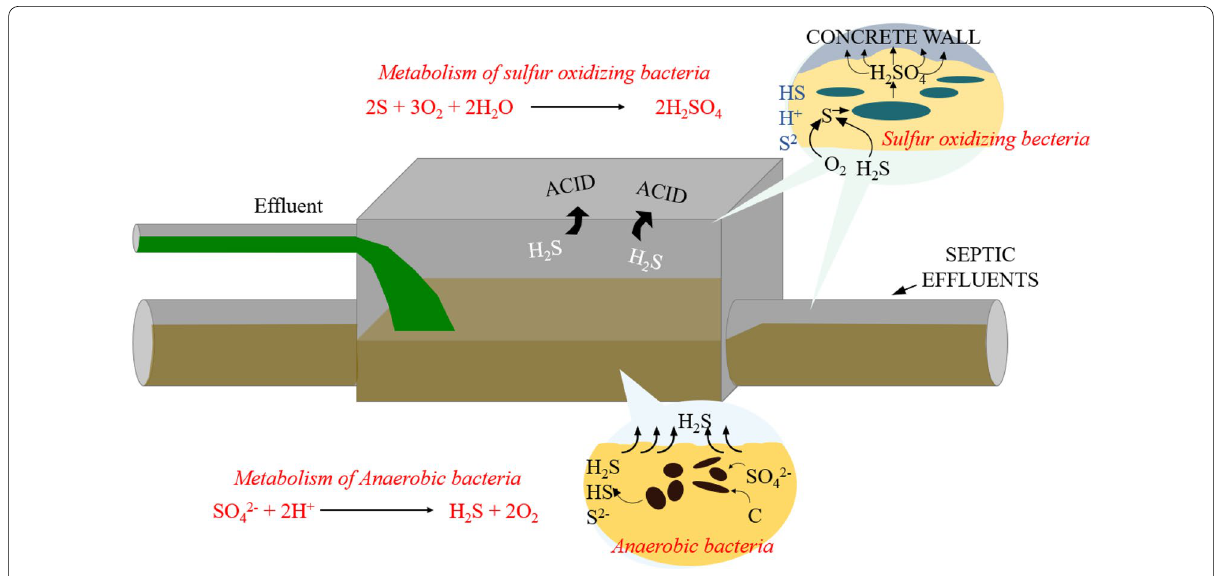
Fig. 1 Deterioration of sewage concrete by sulfate